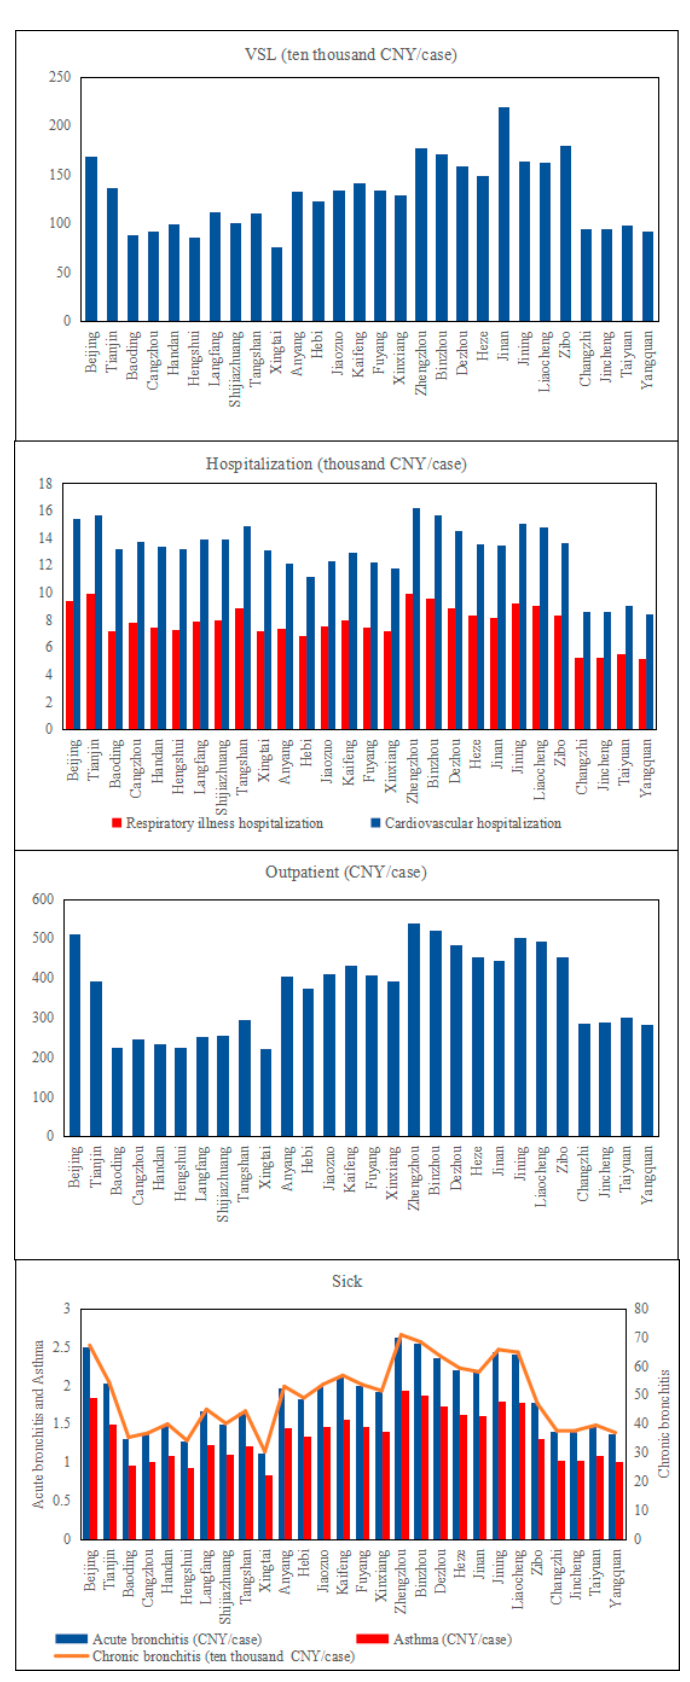
Figure 3. Unit economic loss of each health terminal in ‘2 + 26’ cities.